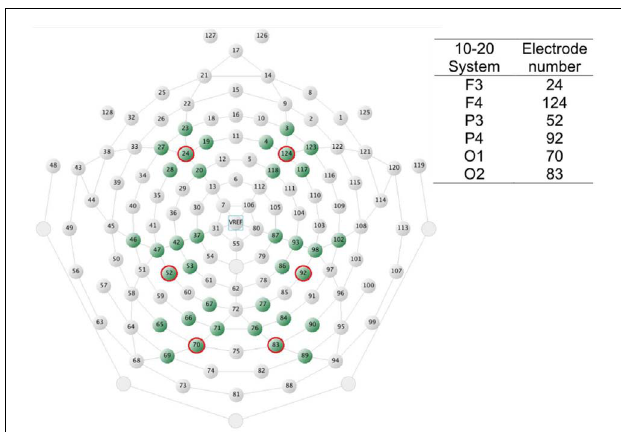
Table 2 | Mean number of segments, divided by condition and inter-stimulus interval (ISI), that were retained for analyses after exclusion of trials with incorrect answers and artifact contaminated segments.